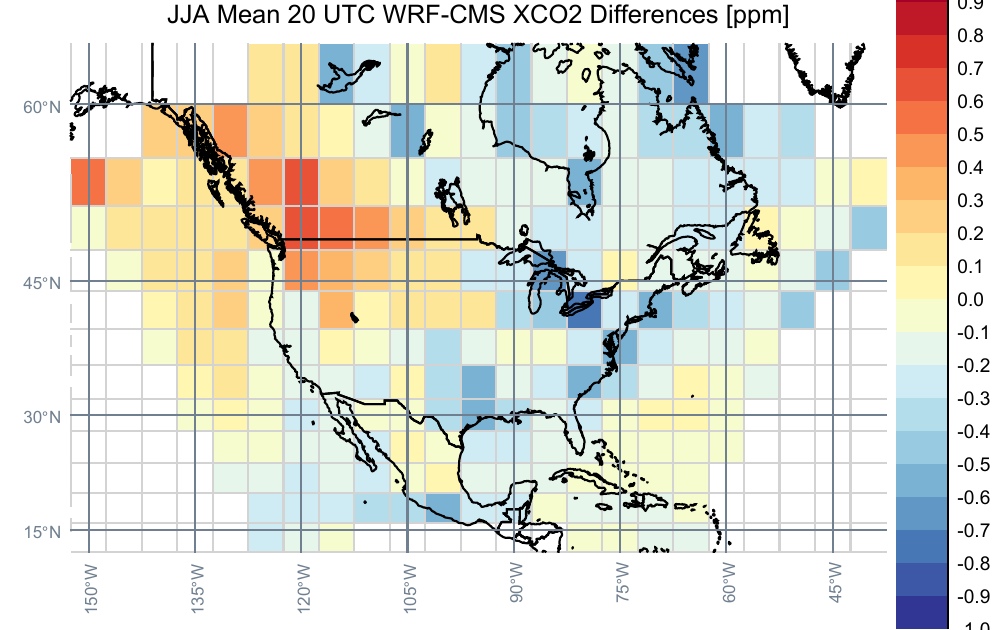
Figure A4. Model-model XCO 2 differences aggregated to the CMS-Flux GEOS-Chem grid assuming a simulated satellite XCO 2 sounding in each grid box for the WRF and CMS-Flux modeling systems at 20 UTC every day in the summer (June, July, August) of 2010. This figure shows the mean model-model differences for the entire column. Compare these full column results to Figure 4b in the main text. Figures A5 and A6 show differences in the upper and lower portions of the